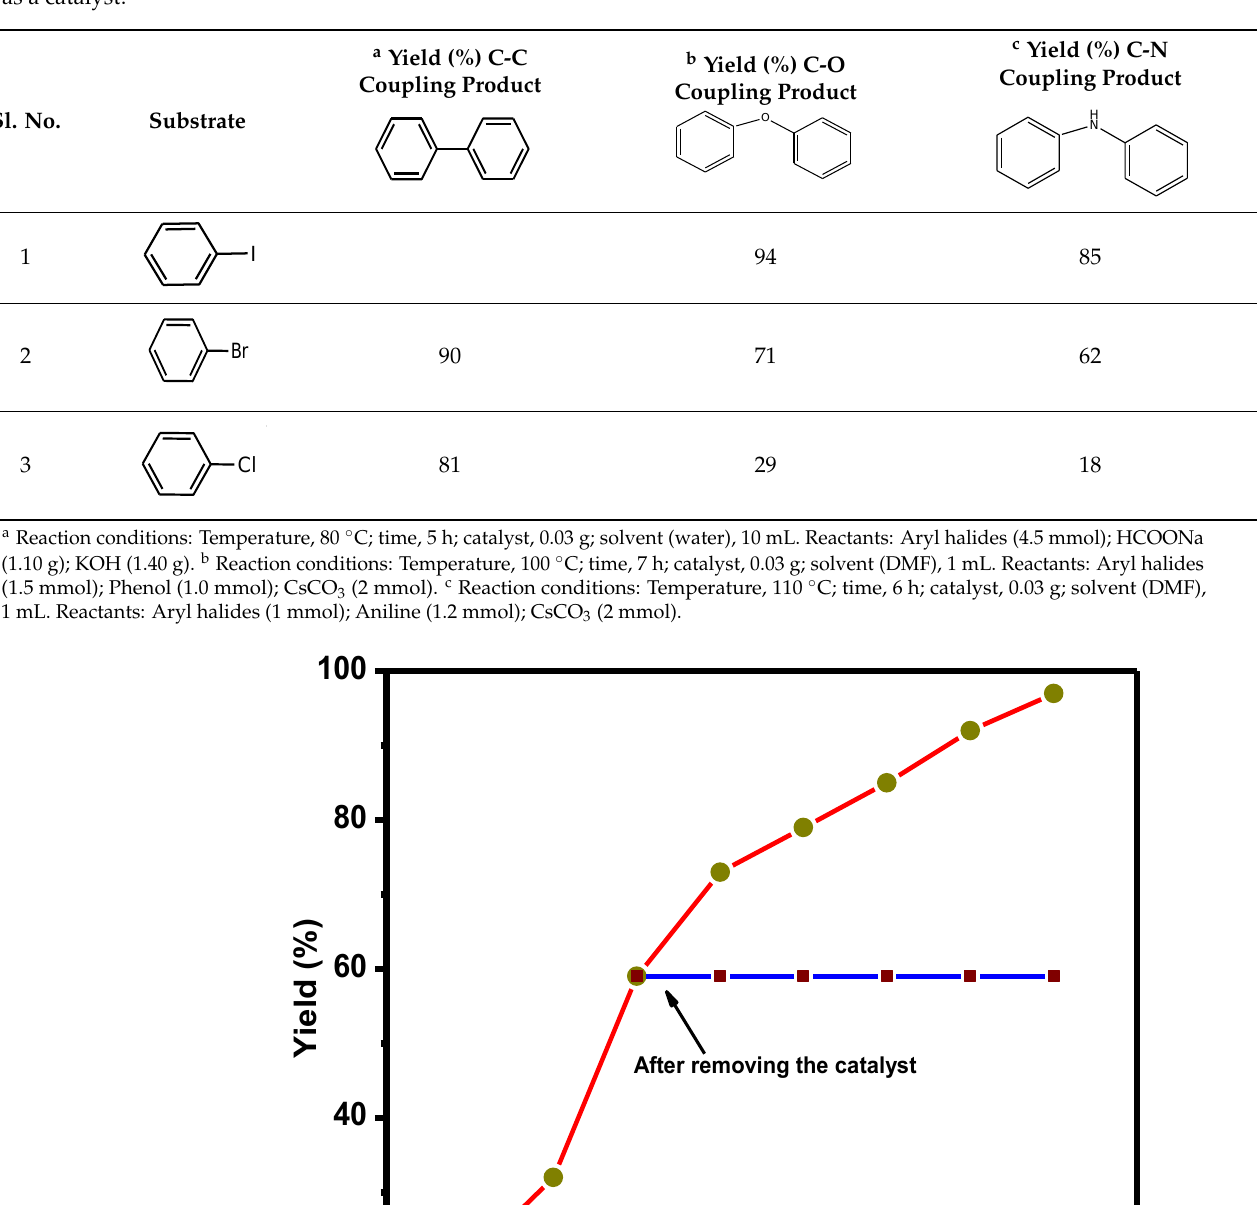
Figure 9. Hence, the Cu metal particles were tightly bonded and stable with functionalized composite material. Table 4. Yields for C-C, C-O, and C-N coupling reactions with different substrates with 5 Cu(0)-AAPTMS@RGO-MCM-41 as a catalyst.